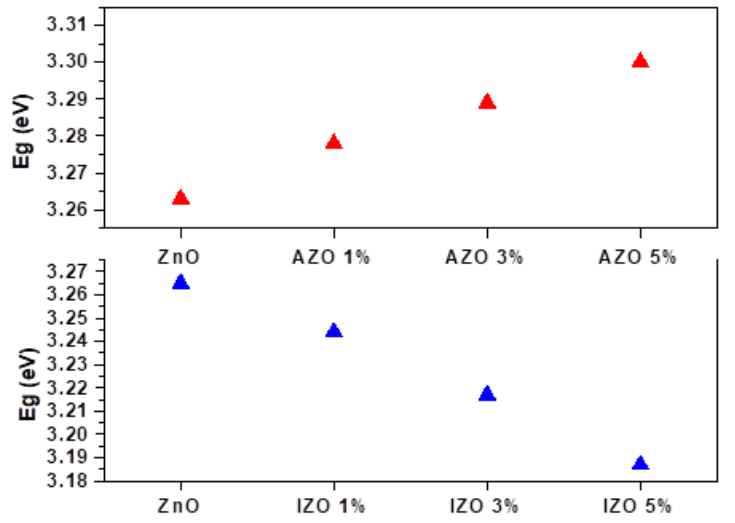
Figure 6. The energy gap of undoped ZnO, AZO, and IZO thin films deposited at various doping concentrations. ing